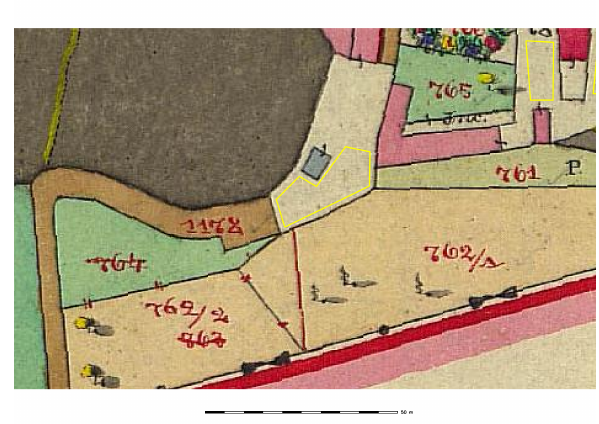
Figure 14. Light tones between two red tones of the boundary line. The extension of one of the check area for the “Boundaries” class is shown in